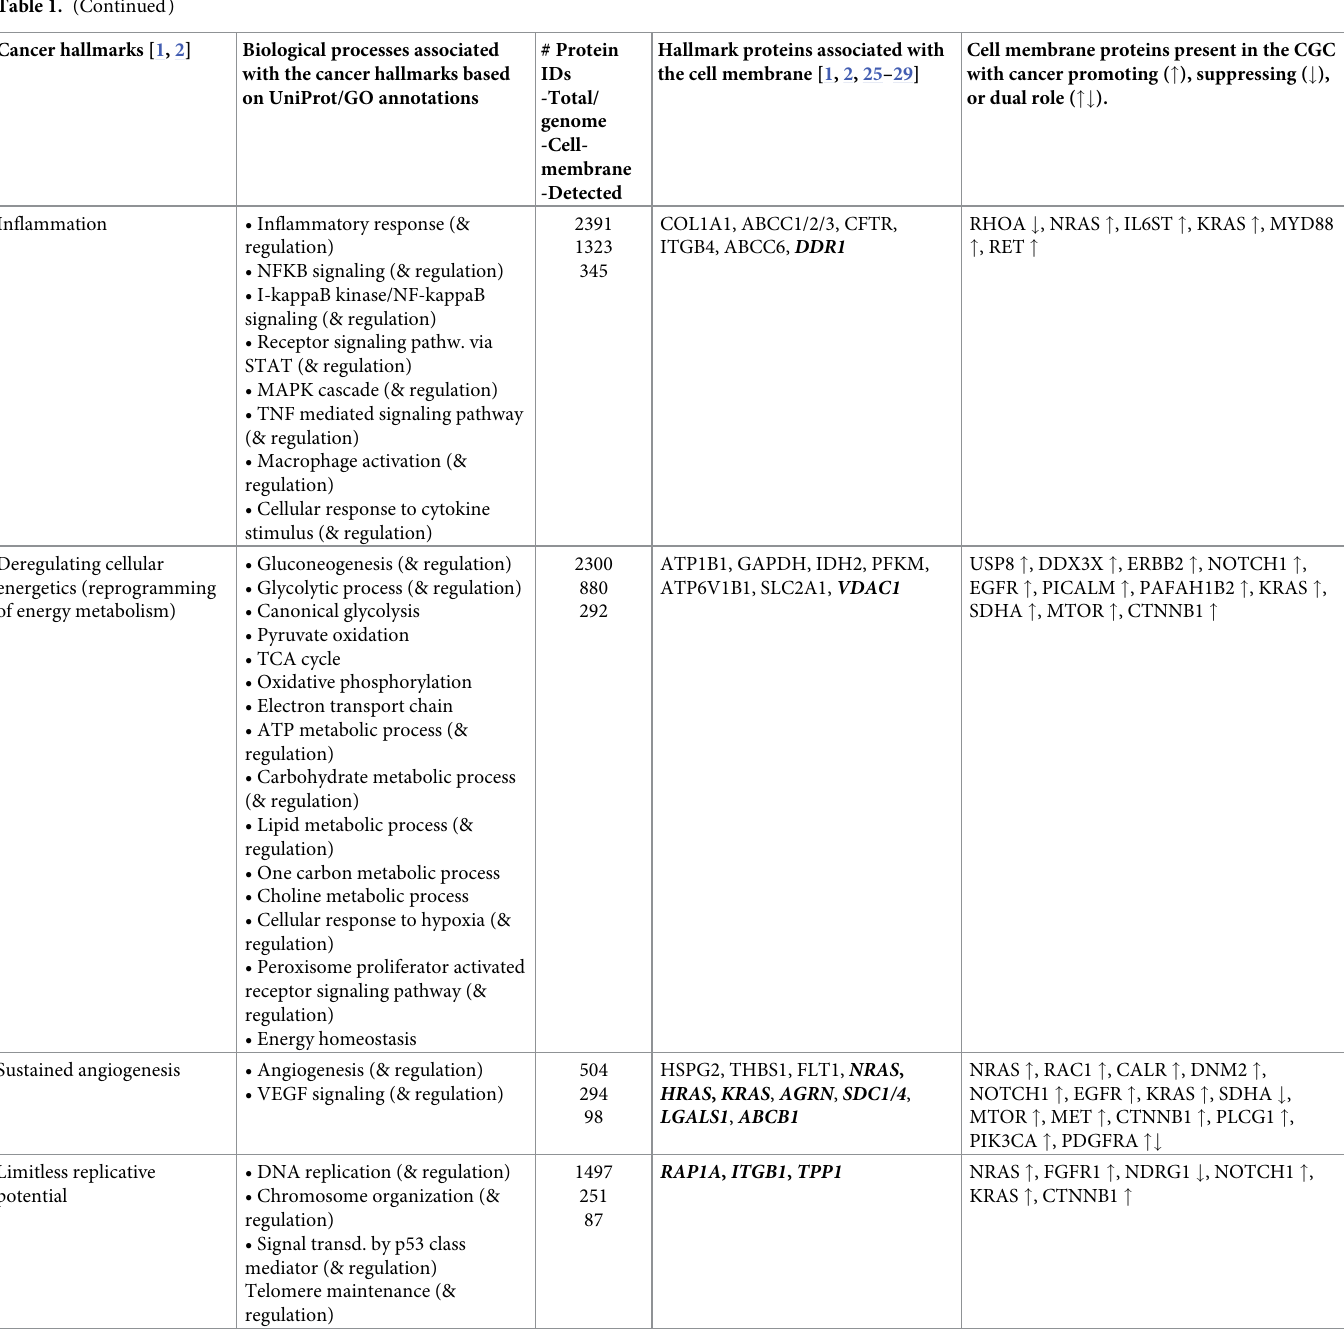
Cancer hallmarks [1, 2] Biological processes associated with the cancer hallmarks based on UniProt/GO